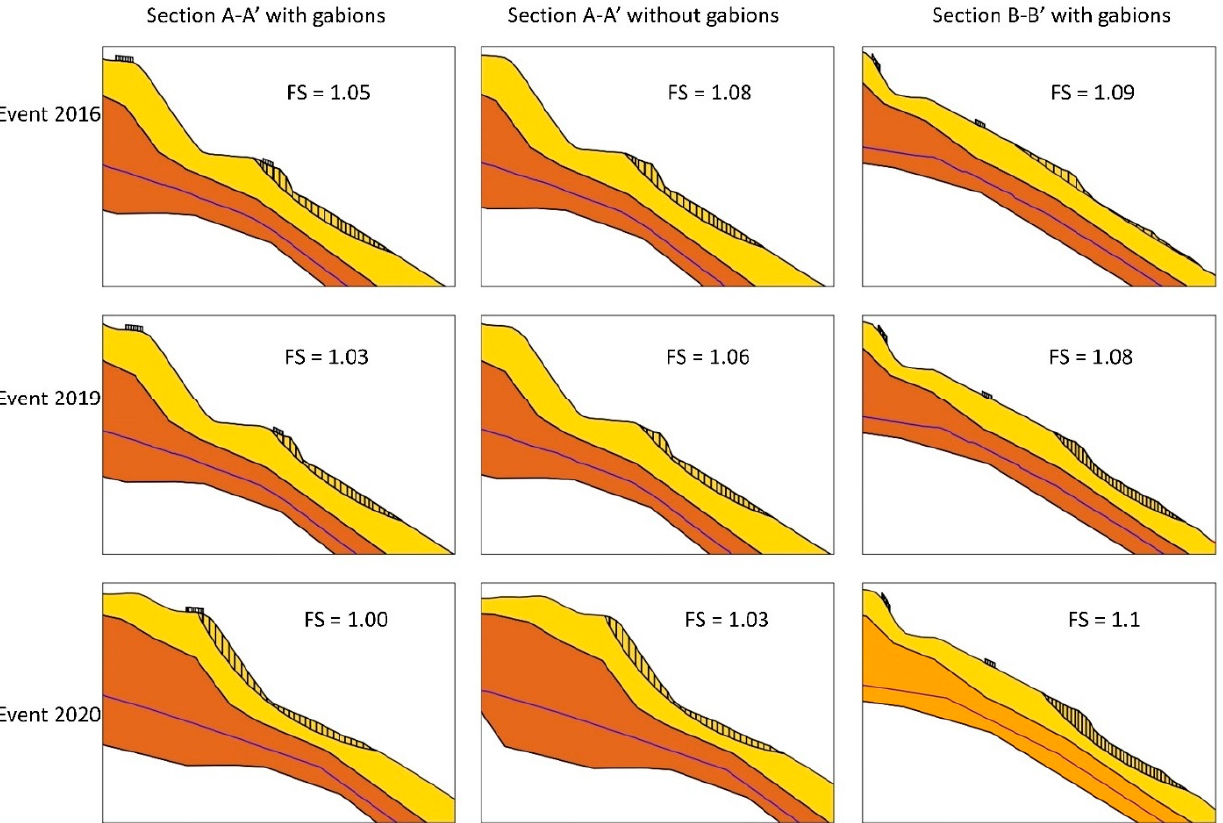
Figure 12. Stability analysis of the 3 events under study. For section A–A’, the analysis was carried out in the presence and absence of structural works, and for section B–B’ only in the presence of retaining works. A zoom of the most critical slip surface identified by the modelling is shown in the fi gure; for the location of the zoom refer to Figure 9.